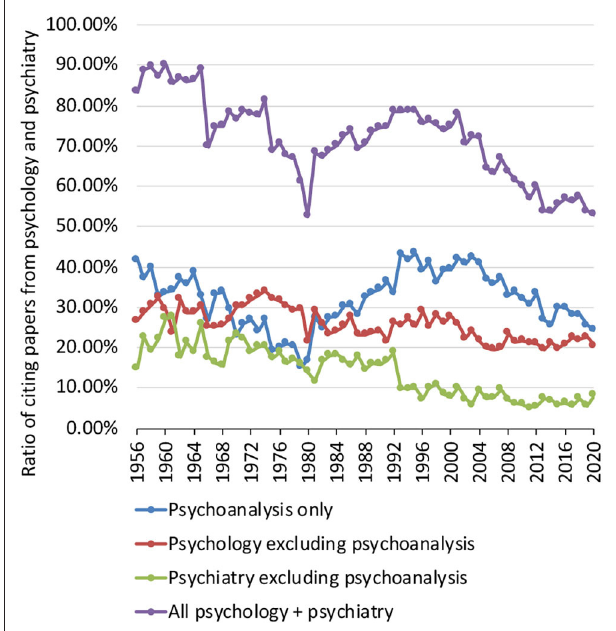
FIGURE 2 | Annual percentage of citing papers coming from psychology and psychiatry. Four percentages were computed: overall percentage considering psychology and psychiatry together (purple), psychoanalysis only (blue), psychology (red), and psychiatry (green) without psychoanalysis respectively.